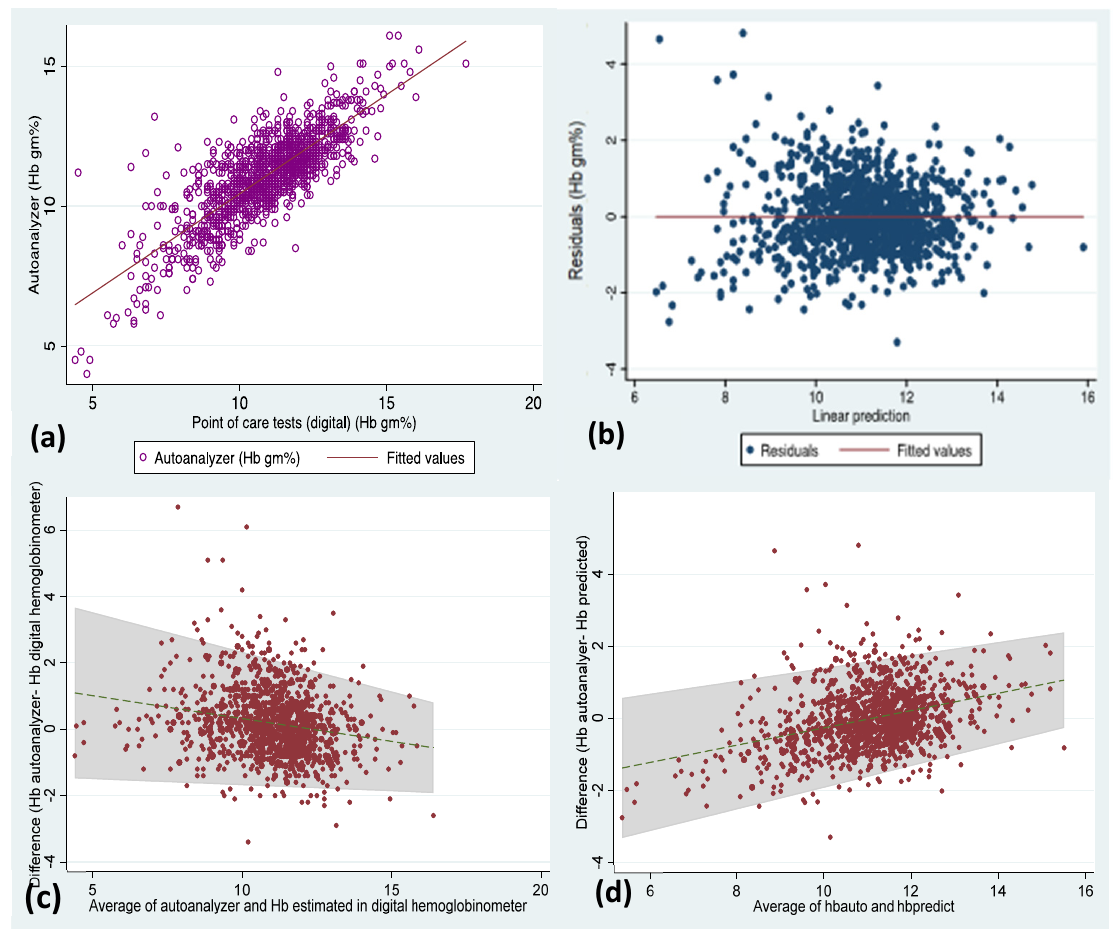
Figure 3. Scatter plot ( a ) for hemoglobin values estimated in all the POCTs against autoanalyzer, residual plot ( b ) of linear regression, Bland–Altman plot ( c ) depicting the mean difference in hemoglobin (Hb Autoanalyzer vs. Hb POCT) and limits of agreement for the whole data included in this study, and ( d ) Bland–Altman plot depicting the mean difference in hemoglobin (Hb Autoanalyzer vs. Hb predicted from correction equation).